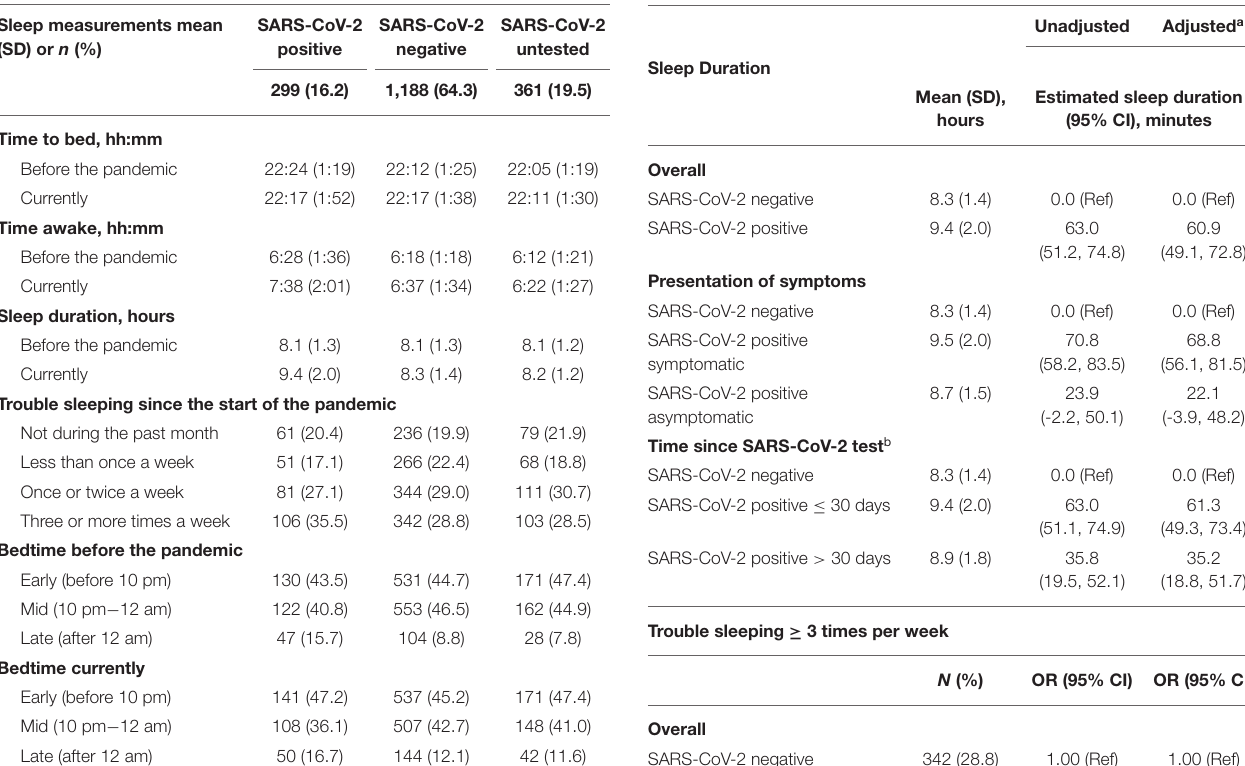
TABLE 3 | Difference in sleep duration and trouble sleeping during the COVID-19 pandemic among participants in the Arizona CoVHORT Study by test group, presentation of symptoms, and time since SARS-CoV-2 test, n =